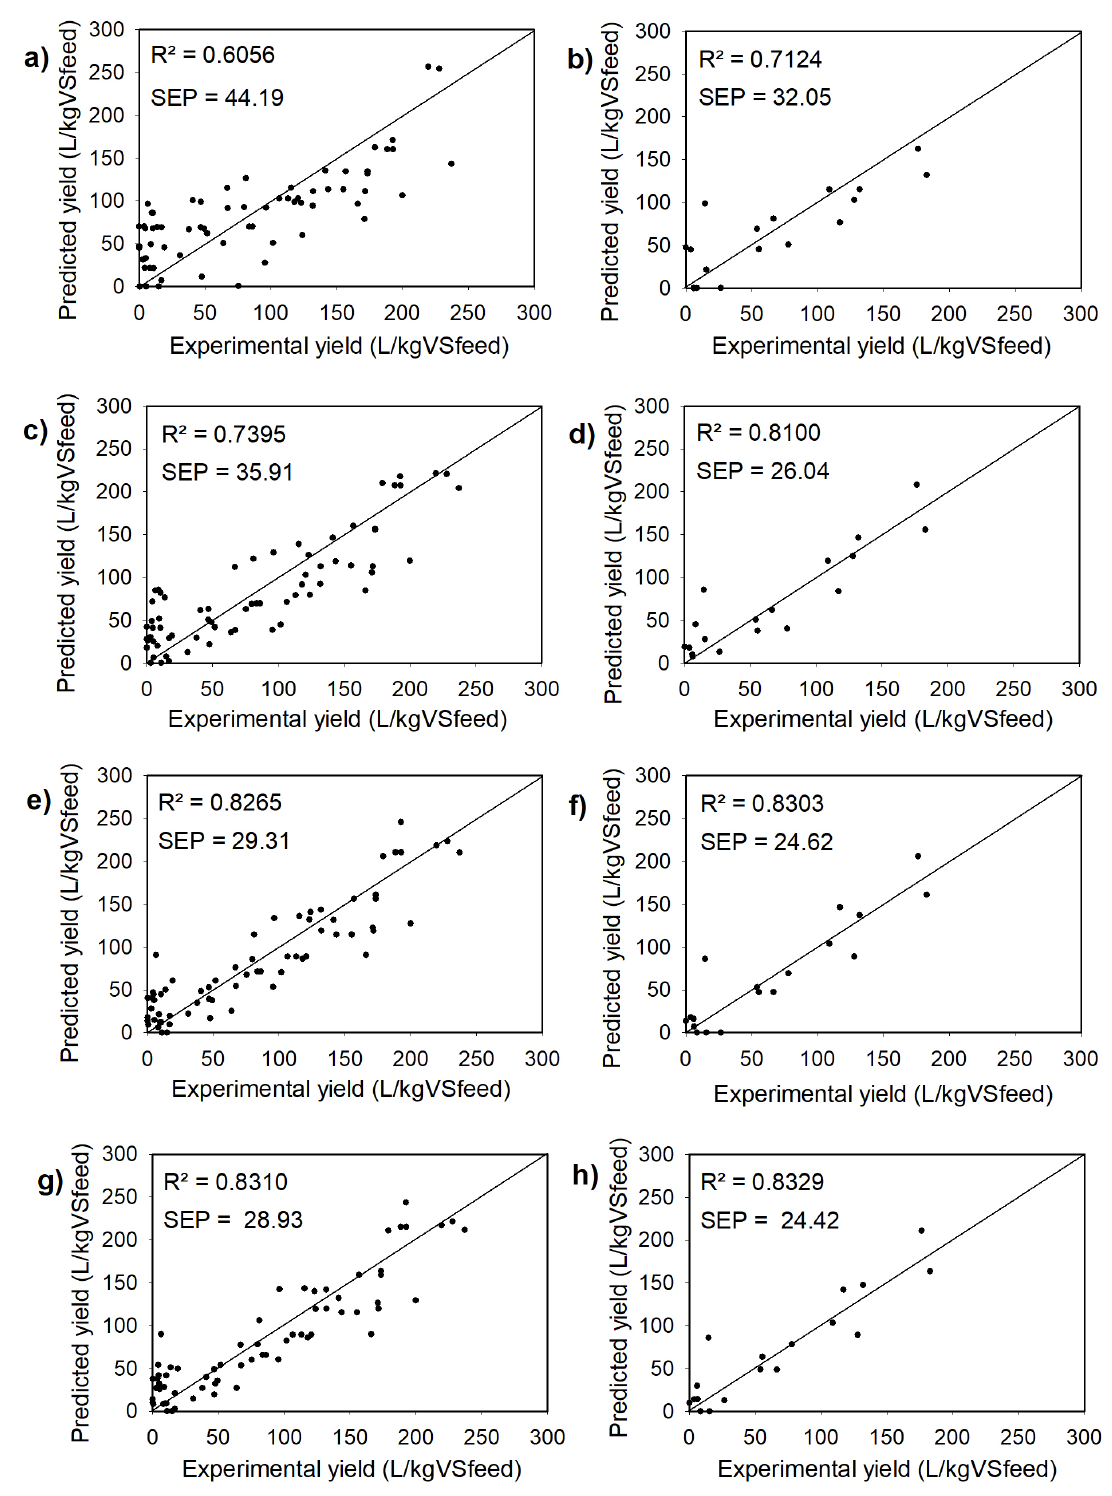
Figure 3 - Comparison between experimental and predicted data for regression and validation, for ( a ), ( b ) first-order, ( c ), ( d ) second-order, ( e ), ( f ) third-order and ( g ), ( h ) fourth-order models. SEP : Standard error of